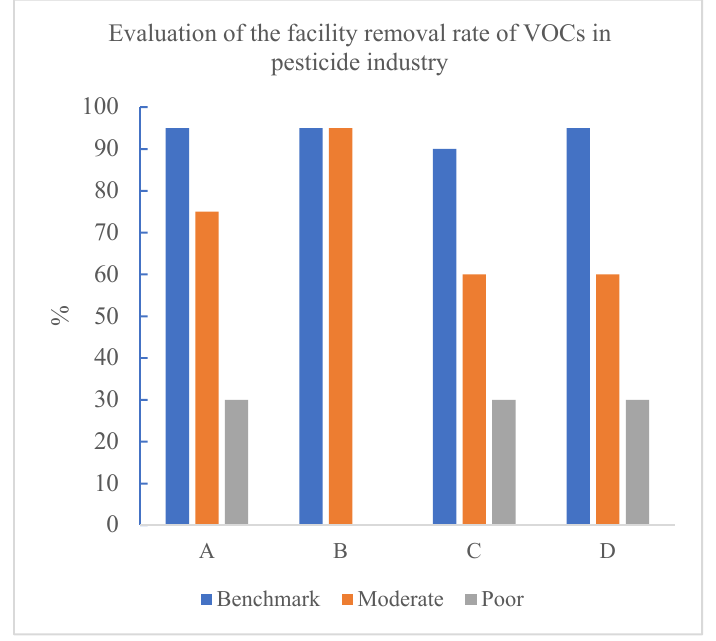
Figure 5. Evaluation of the facility removal rate of VOCs in pesticide industry. (A: production process; B: solvent storage and transportation; C: sewage station; D: hazardous waste temporary storage).